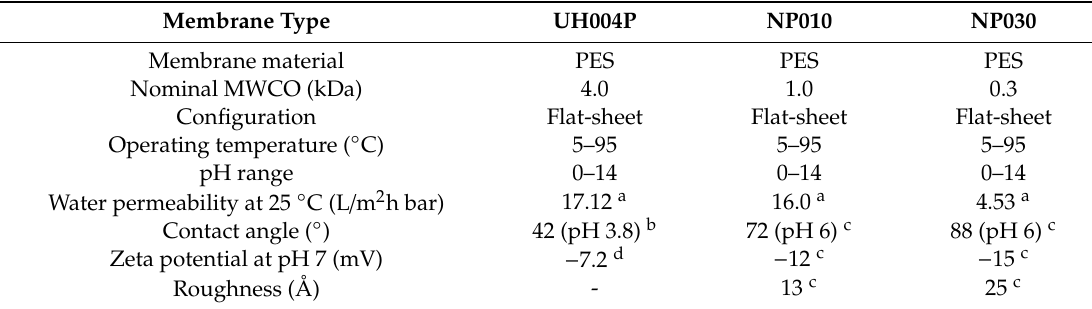
Table 1. Characteristics of selected